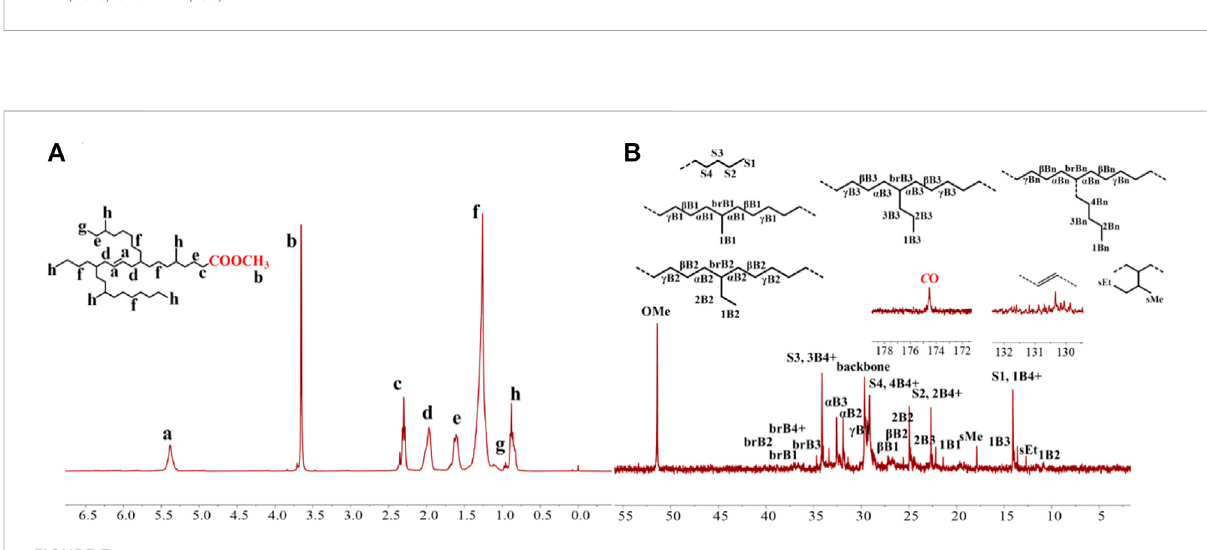
contain > 1 polar functionalized group in each chain. The microstructure of a representative ethylene/MA co-oligomer (entry 1, Table 3) was elucidated by 1 H and 13 C NMR analyses (Figure 7). The assignments of the 1 H NMR resonances of ethylene/MA co-oligomer reveal a high amount of terminal methyl groups, a C=C-C H 2 -group, a methoxyl group (OC H 3 ), a C H 2 CH 2 COOMe, a C H 2 COOMe and an internal double bond (Figure 7A). Furthermore, the corresponding 13 C NMR spectra reveal the existence of different branches with different chain lengths (ethyl, methyl, n -propyl, etc.), a branch-on-branch structure, an ester carbonyl group, an O C H 3 group and an internal double bond (Figure 7B). The long-chain branches and those carrying chain end ester groups accounted for the majority of all chain branches and the hyperbranching was also detected based on the presence of sec -butyl groups (Cotts et al., 2000). The ester groups in the hyperbranched ethylene- MA co-oligomers are predominately incorporated at